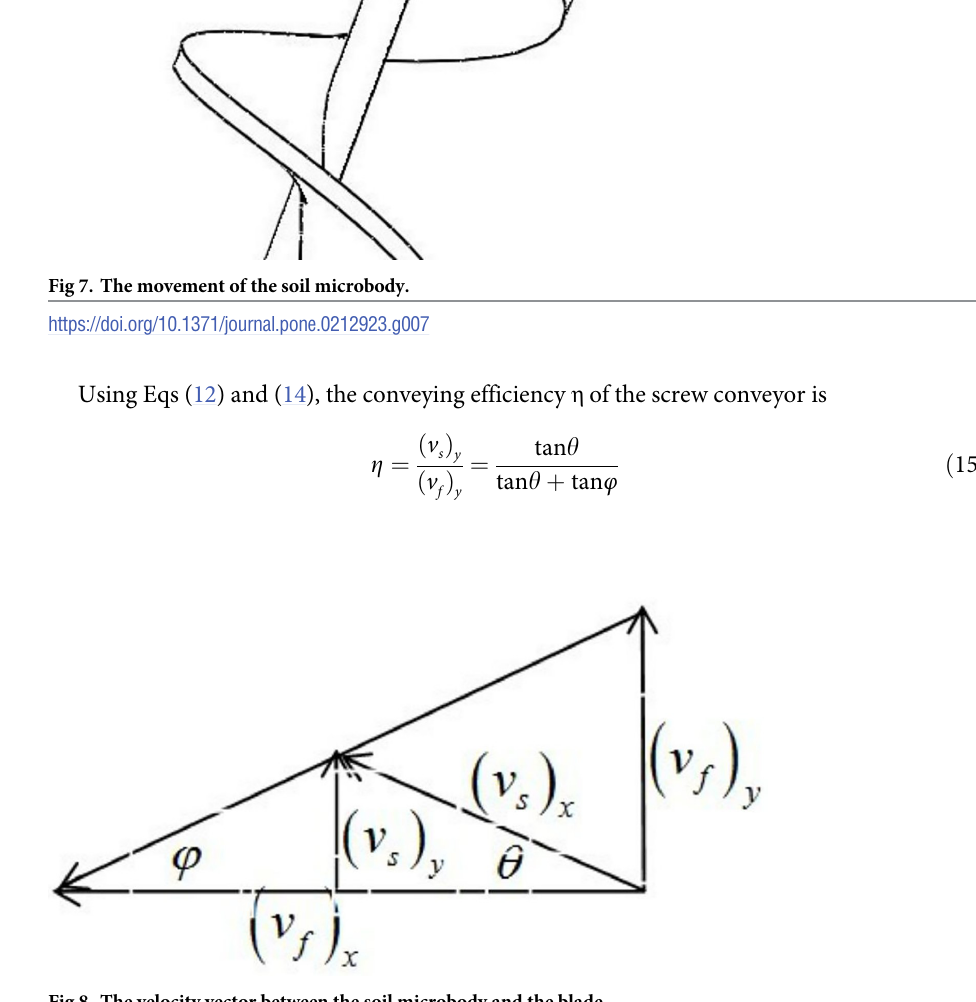
Fig 8. The velocity vector between the soil microbody and the